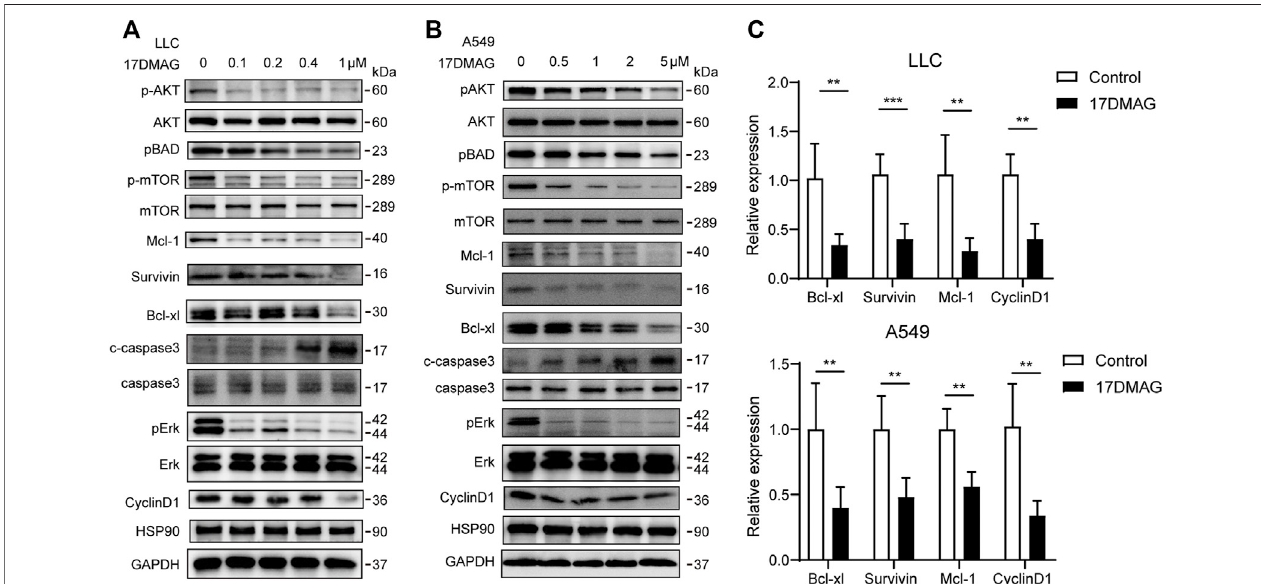
FIGURE 5 | Inhibiting HSP90 reversed AKT1/ERK activation in lung cancer cells. (A) LLC cells were treated with indicated concentrations of 17-DMAG and then subjectedtowesternblotformeasuringproteinlevelsbyindicatedantibodies. (B) A549cellsweretreatedwithindicatedconcentrationsof17-DMAGandthensubjected to western blot for measuring protein levels by indicated antibodies. (C) The total RNA of 17-DMAG-treated LLC cells and A549 cells were extracted, and a qPCR method was adopted to test the transcription level of indicated genes. The result was obtained from three independent experiments. ** p < 0.01, *** p <